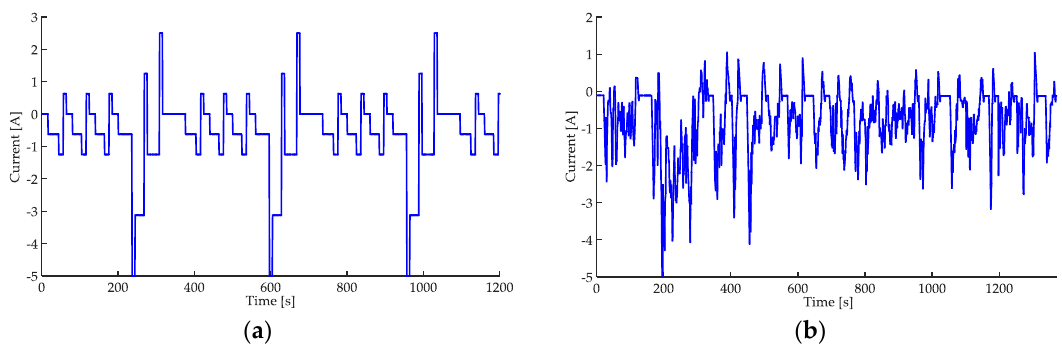
Figure 5. Load current profiles: ( a ) DST current profile; ( b ) UDDS current profile.